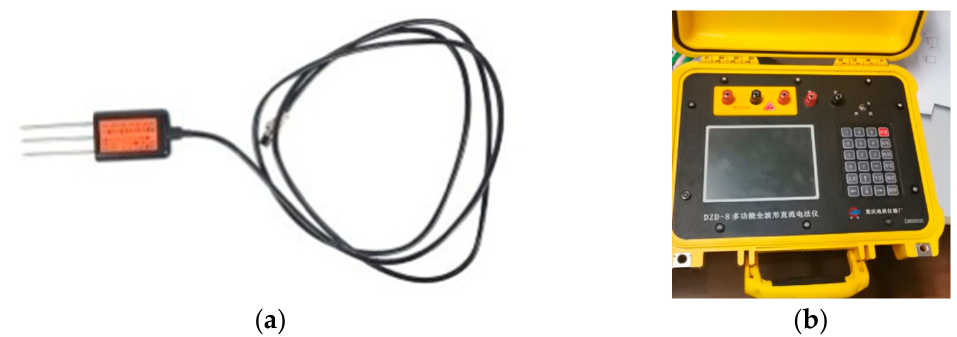
Figure 8. Monitoring instrument: ( a ) LD-EC soil moisture sensor, ( b ) DZD-8 multifunctional full- waveform DC electrostatic instrument. Table 2. Technical parameters of the soil moisture sensor.